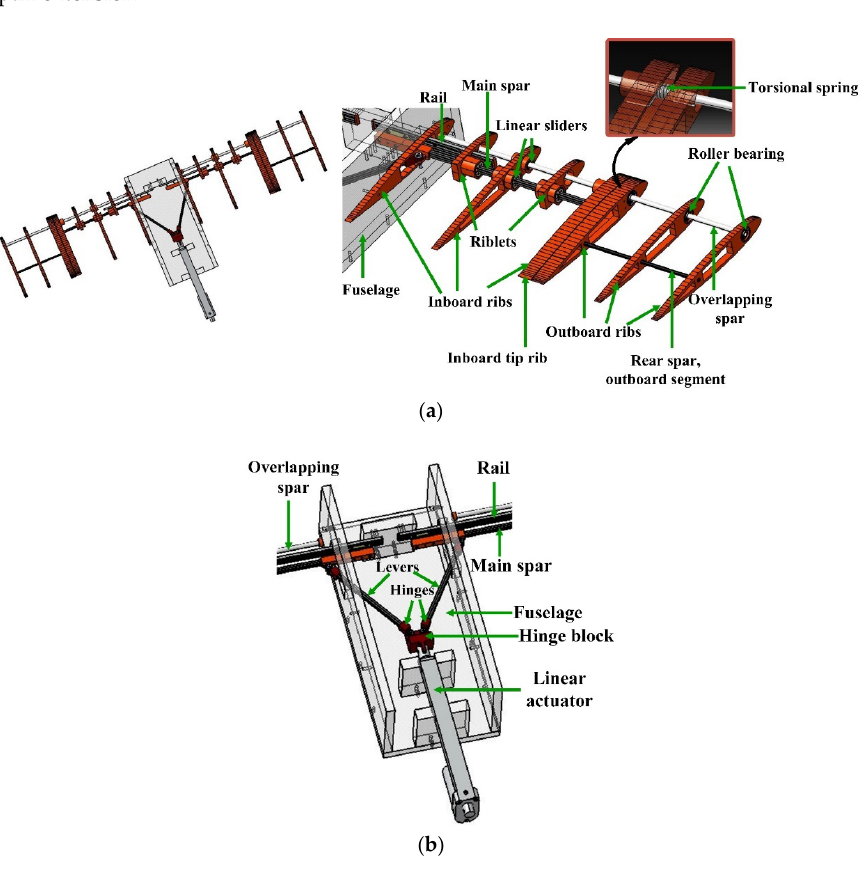
Figure 3. Detailed cad model of the ASAPP wing: ( a ) ASAPP wing. ( b ) Actuation mechanism. On the other hand, the outboard segment is connected to the inboard one using an overlapping hollow circular spar made from Aluminum and located at 15% of the chord (as shown in Figure 2). The overlapping spar is the main loading bearing structural com- ponent in the outboard segment. It should be noted that the portion of the overlapping spar, located in the inboard segment, is always attached to two ribs (tip and middle) of the inboard segment, regardless of the span extension to maximize load transfer between the two segments, as shown in Figure 3. The overlapping spar translates relative to these two ribs using linear slide bearings with a circular cross-section. The outboard segment is covered by MonoKote lightweight plastic wrap film to maintain the aerodynamic profile. The skin is supported by three ribs (in each outboard segment) to minimize out-of-plane deformations and transfer the aerodynamic loads to the overlapping spar. It should be noted that the three ribs (and the MonoKote skin) can rotate/pitch around the overlapping spar using ball bearings. A CFRP solid circular rear spar at 60% chord is attached to the outboard segment to ensure that the three ribs rotate together around the overlapping spar. Pitch variations occur passively whenever the lift is generated by the outboard segment, mainly because the overlapping spar (at 15% chord) is ahead of the aerodynamic center (around 25% of the chord) of the segment. To limit the amount of pitch, a torsional spring surrounds the overlapping spar and connects the inboard and outboard segments together (Figure 3a).